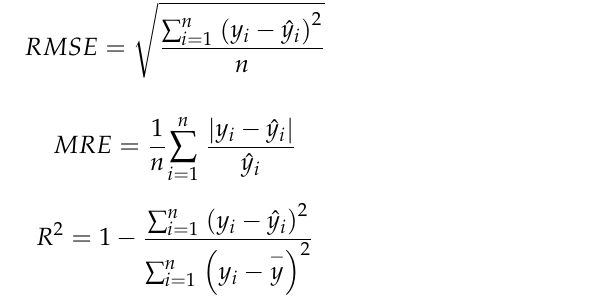
Figure 7. ( A ) Changes in brightness temperature di ff erence of OFT (0.01 − 0.40 mm) in summer; ( B ) Change of BTD of OFT (0.50 − 3.00 mm) in summer; ( C ) Change of BTD of OFT (0.01 − 0.40 mm) in autumn; ( D ) Change of BTD of OFT (0.50 − 3.00 mm) in autumn.